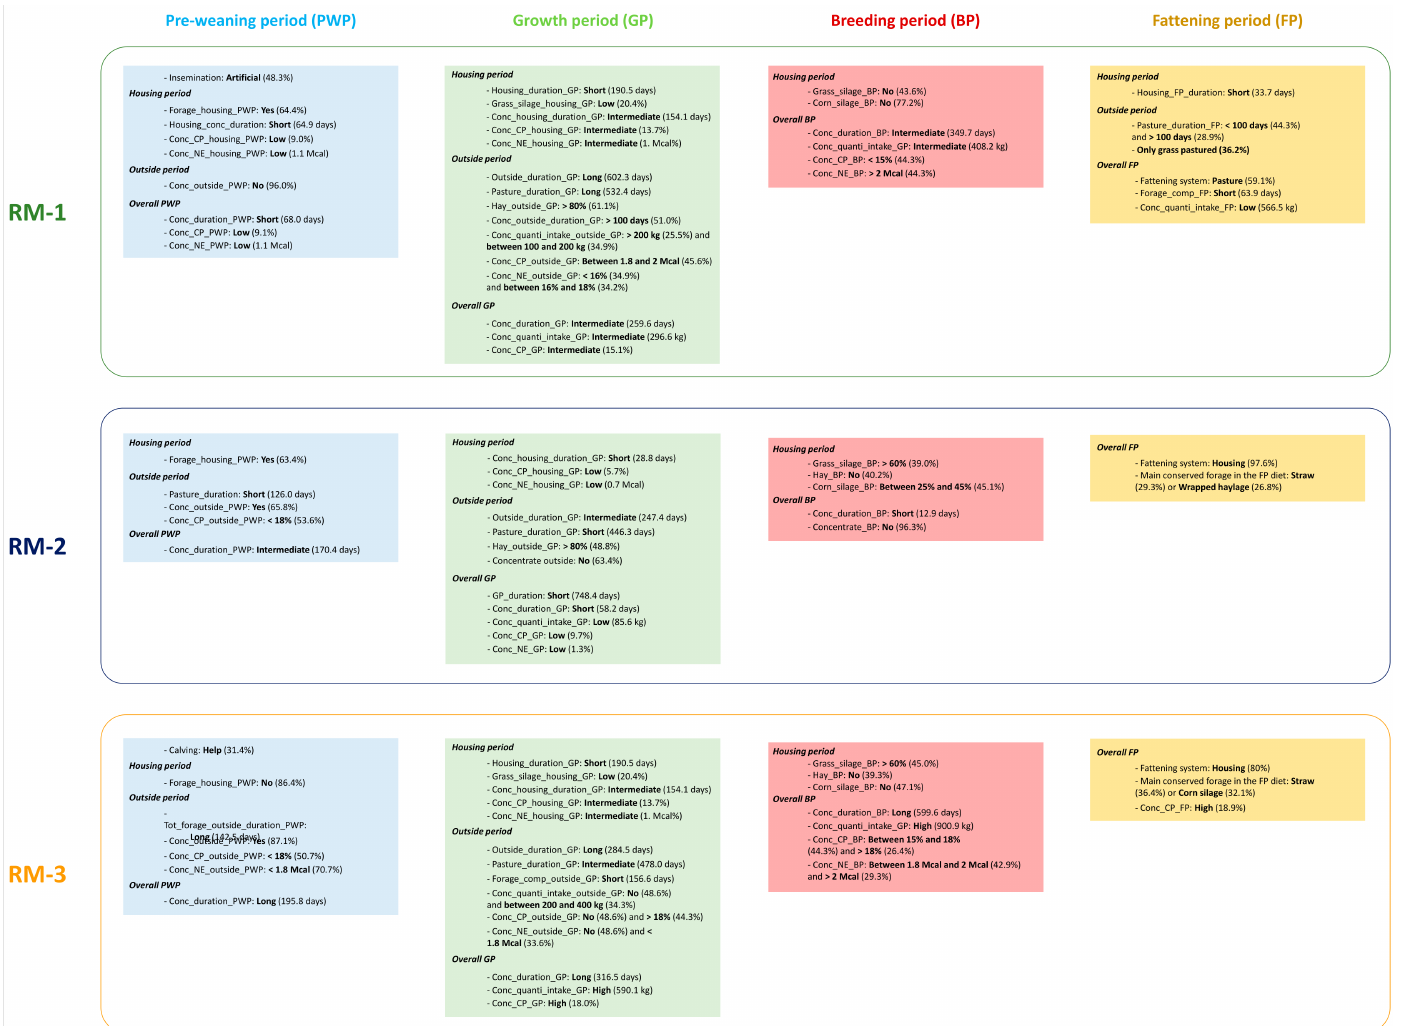
Figure 3. Description of the three rearing managements (RM) applied during the cull cows’ whole life, with a focus on the rearing factors characterizing the most each rearing managements and described in Tables